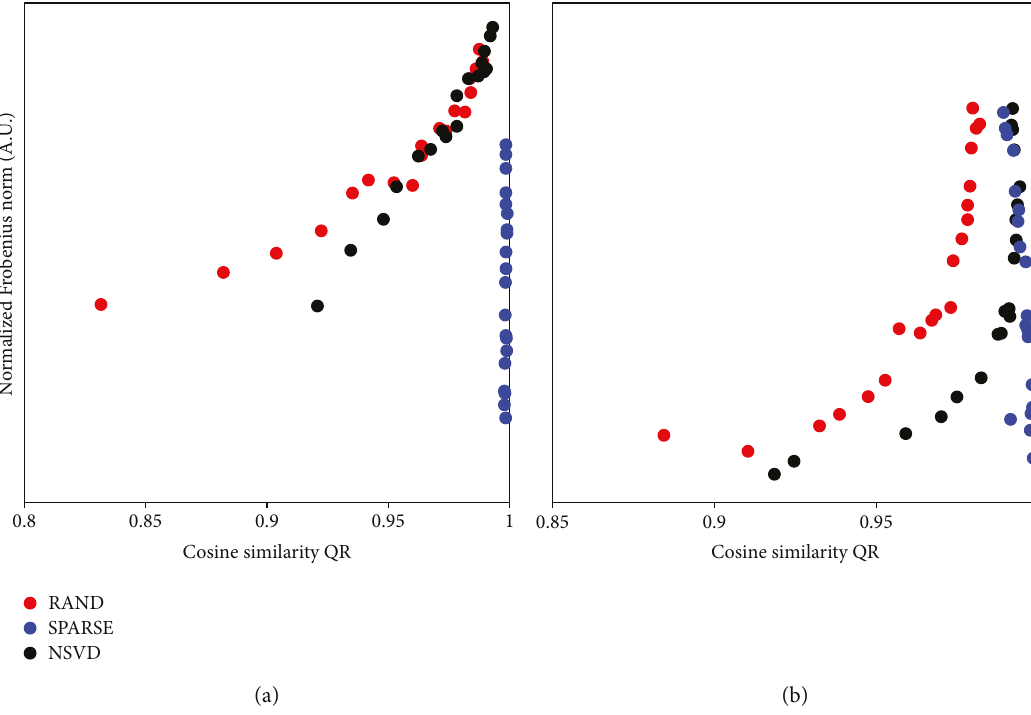
Figure 5: Relationship between the estimation quality QR and the approximation error of NNMF (i.e., Frobenius norm) with di ff erent initialization techniques. (a) Independent synergies W I . (b) Dependent synergies W D . In both cases, for RAND and NSVD initialization, higher synergy estimation accuracy QR is obtained with a higher approximation error via NNMF, while SPARSE initialization is not dependent on the NNMF convergence